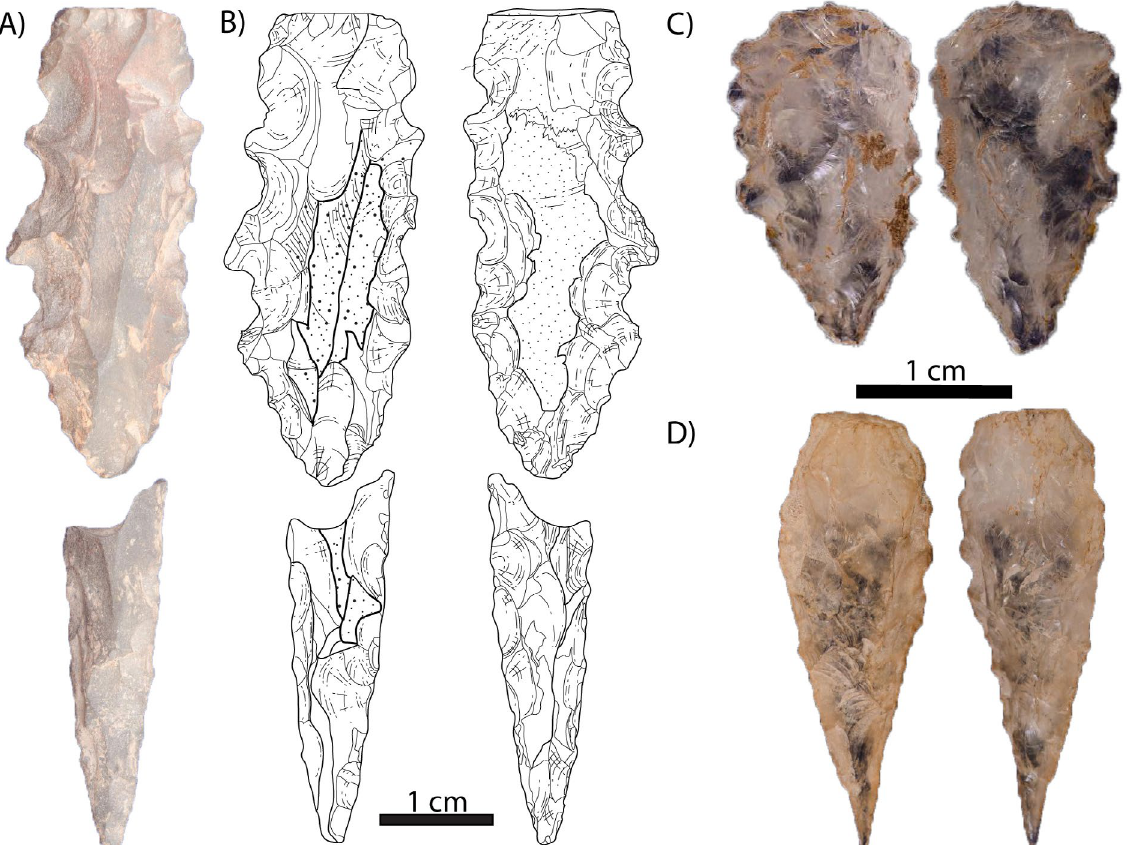
Figure 3. Examples of archaeologically recovered Kimberley Points from Maloney et al. (2014): A) Kimberley Dentate Point recovered from Mt. Behn B) Mt. Behn point sketch C) Kimberley Point (serrate) from CG3 D) Kimberley Point (serrate) recovered from